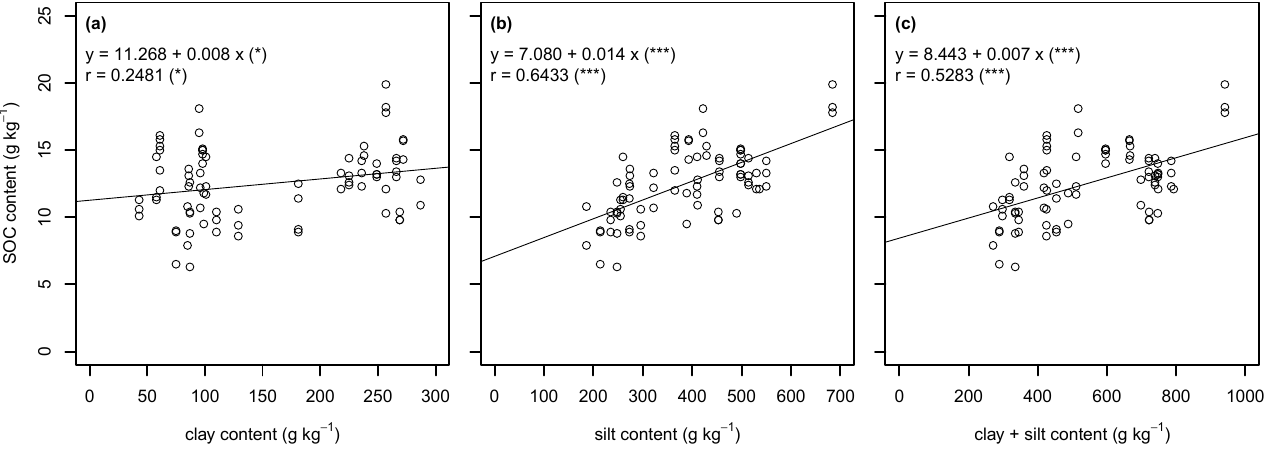
Figure 3. Simple linear regression of soil organic carbon (SOC) content against ( a ) clay content, ( b ) silt content, and ( c ) clay + silt content. The regression functions and Pearson product–moment correlation coefficients ( r ) are given for each parameter fitting. The significance levels of the regression function slopes and r , indicating a difference from zero, are as follows: (***) p < 0.001; (*) p < 0.05. For sites with a slope inclination < 14%, the soil loss correlated negatively with the SOC content in the first rainfall period (Figure 4c) and positively with the clay content in the second rainfall period (Figure 5). For sites with a slope inclination > 14%, the soil loss correlated positively with the silt content, clay + silt content, and SOC content in the first rainfall period (Figure 4).